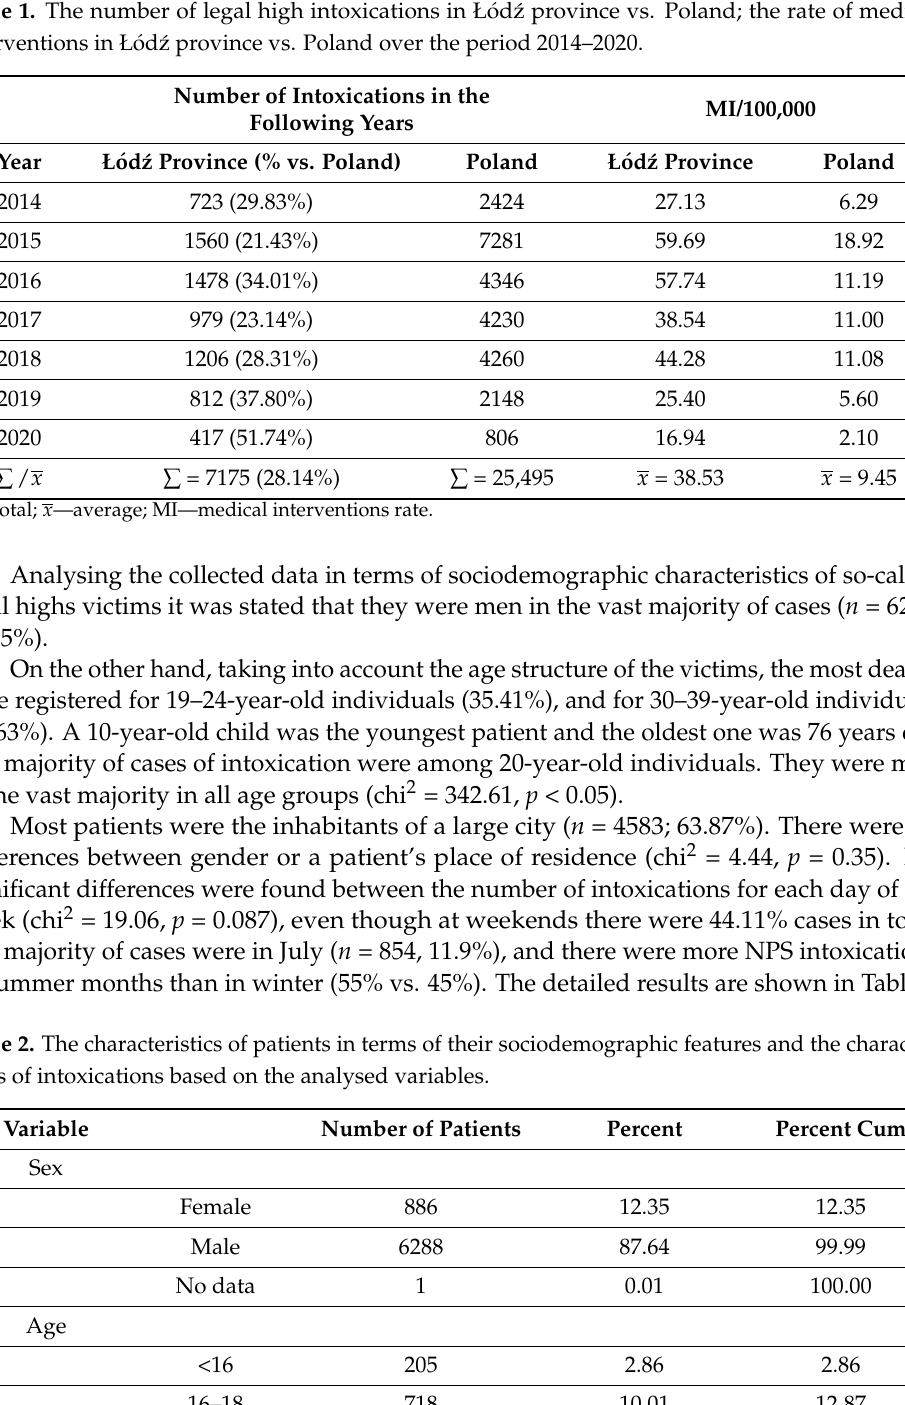
Table 1. The number of legal high intoxications in Ł ó d´z province vs. Poland; the rate of medical interventions in Ł ó d´z province vs. Poland over the period 2014–2020. Number of Intoxications in the Following Years Year